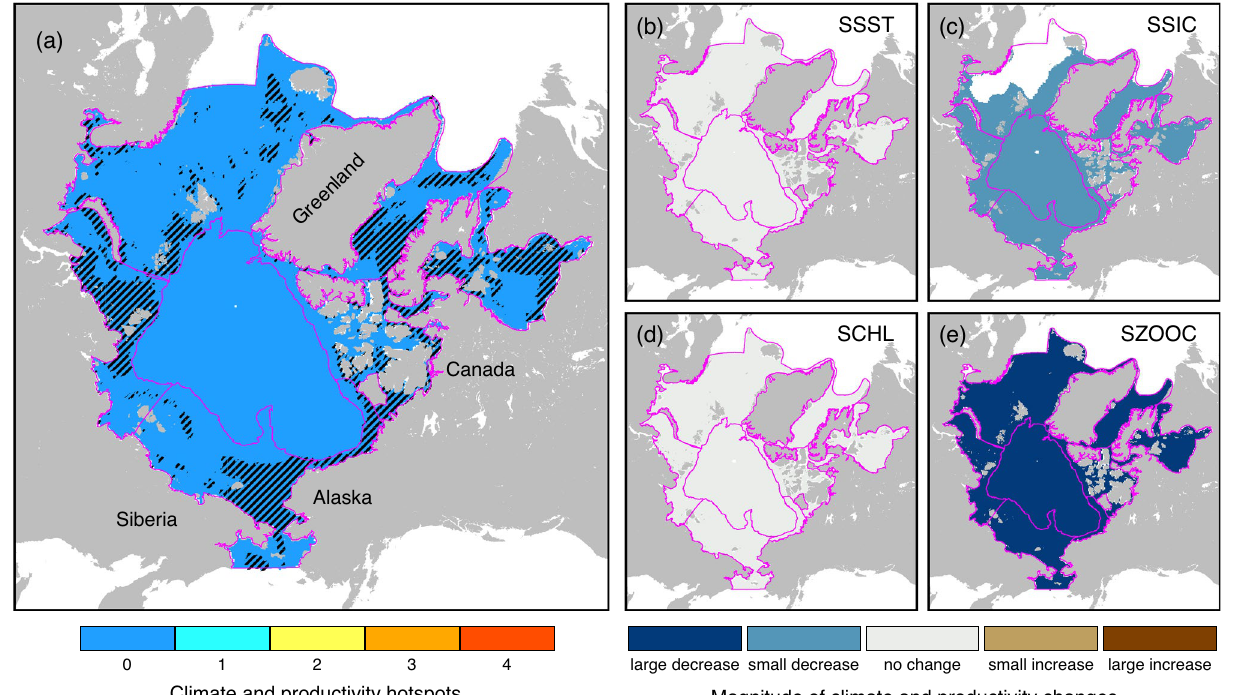
Figure 6. ( a ) Climate and productivity hotspots in Arctic marine areas defined as areas of overlap of two or more large changes in summer ( b ) sea surface temperature (0.21 °C ≤ SSST ≤ 0.76 °C), ( c ) sea ice concentration (− 2% ≥ SSIC ≥ − 76%), ( d ) chlorophyll-a concentration (0.26 mg·m −3 ≤ SCHL ≤ 0.73 mg·m −3 ), and ( e ) accrual (defined as areas with species gains ≥ 1 species/decade) over the entire study period. The maps were created using GMT 6.3.0 (https:// docs. gener ic- mappi ng- tools. org/6. 3/ gmt.